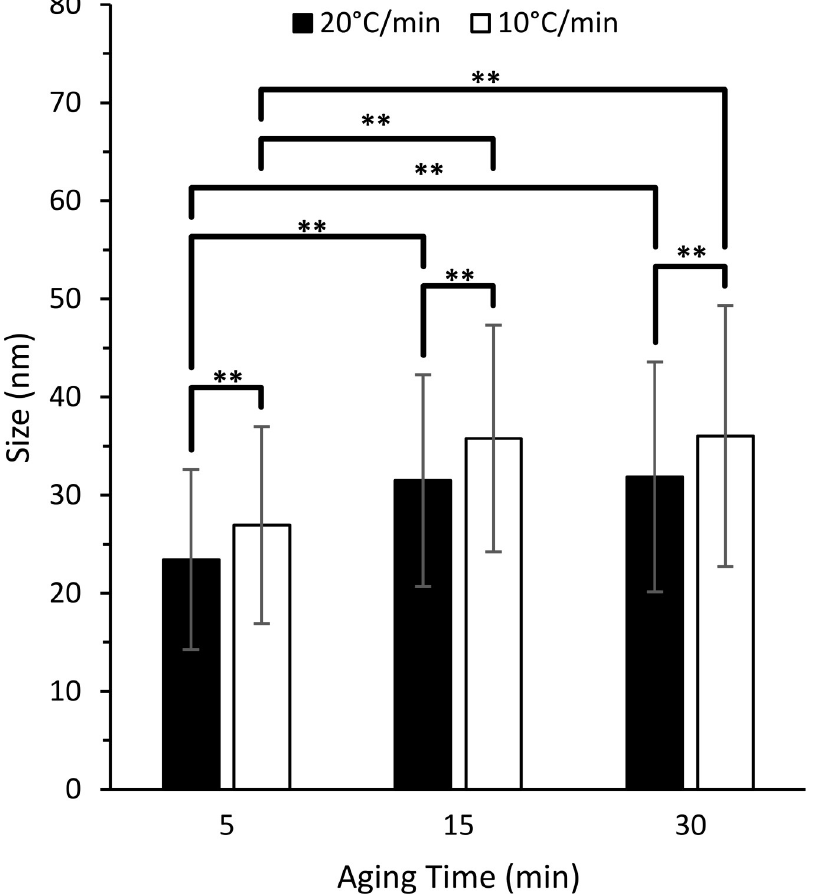
Fig 3. Average MnO NP diameters achieved with different ramping rates and aging times at 300˚C. A faster ramping rate and a shorter aging time produced the smallest NPs. A total of 800–900 NPs were analyzed from TEM images per temperature condition. Error bars are average ± standard deviation. �� p < 0.01 was defined as highly significant.